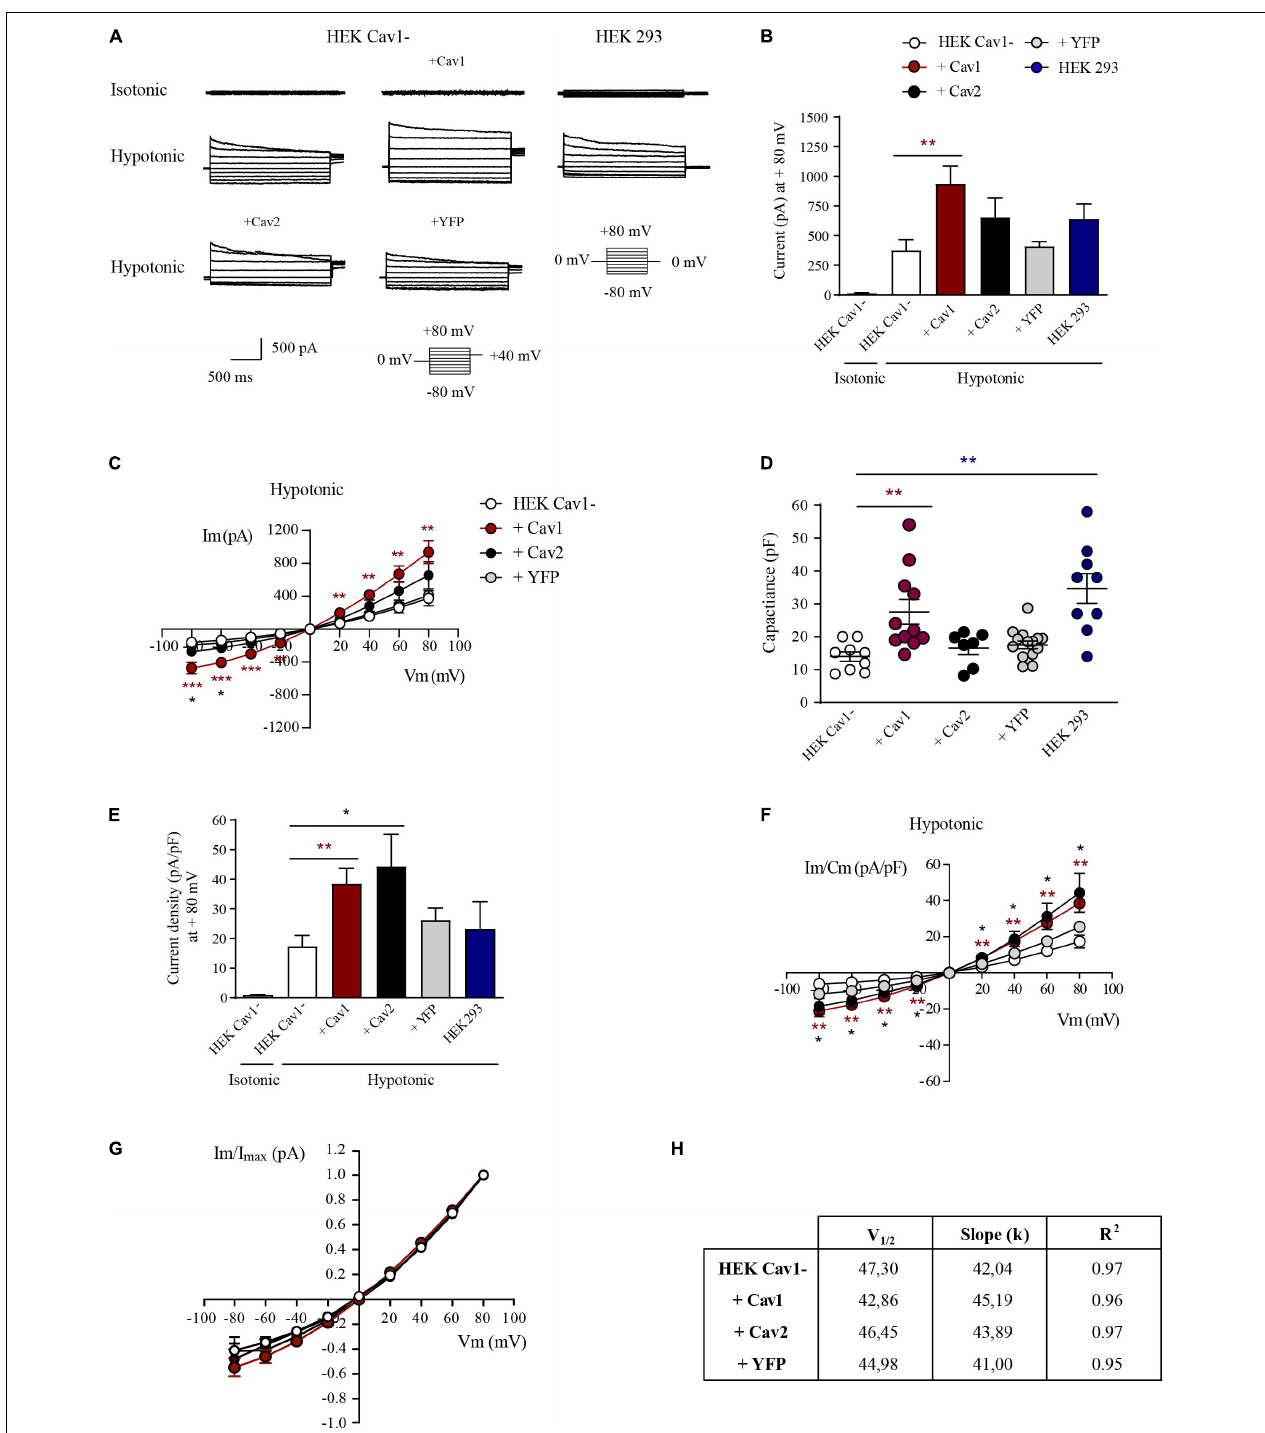
FIGURE 3 | Caveolins modulate the current density of LRRC8-mediated VRAC. (A) Representative current traces elicited by 200 ms voltage sweeps ranging from –80 to +80 mV in 20 mV increments from a holding potential of 0 mV and a final tail pulse at +40 mV after each step (not shown). Current traces shown were recorded under isotonic conditions and after 3 min of exposure to the hypotonic bath solution. (B) Instantaneous current quantified at the peak of + 80 mV in HEK Cav1-, HEK Cav1- + Cav1, HEK Cav1- + Cav2, HEK Cav1- + YFP, and HEK 293 cells. All data are represented as means ± SEM, and comparisons between groups are analyzed by unpaired t -tests (* p ≤ 0.05, ** p ≤ 0.005, and *** p ≤ 0.001). Comparisons between HEK Cav1- and HEK Cav1- + Cav1 are shown with asterisks. (C) Current-voltage relationship of instantaneous currents measured at the peak in each experimental group. (D) Membrane capacitance measured in